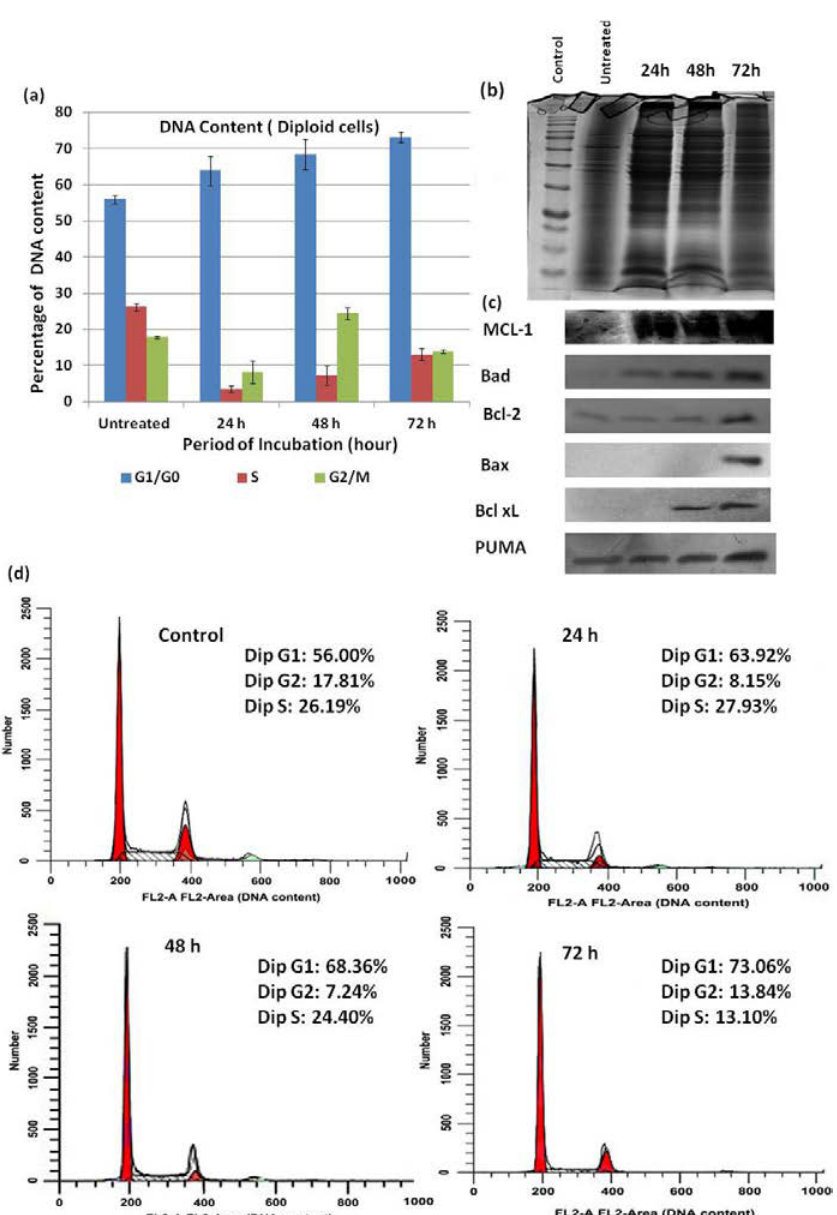
Figure 7. ( a ) Effect of DMHE on the HT-29 cell cycle. Cells treated with DMHE (25 µg/mL) for 24, 48 and 72 h, and analyzed by flow cytometry after staining with PI. Percentages of diploid cells (DNA content) at G were determined after 24, 48 and 72 h incubation periods; ( b ) coomasie blue stained SDS-PAGE gels demonstrating equivalent loading of proteins; ( c ) the expression of anti-apoptotic and pro-apoptotic proteins as detected by western blotting; and ( d ) histogram showing quantitative percentages of diploid cells or DNA content in each cell cycle phase without treatment and with